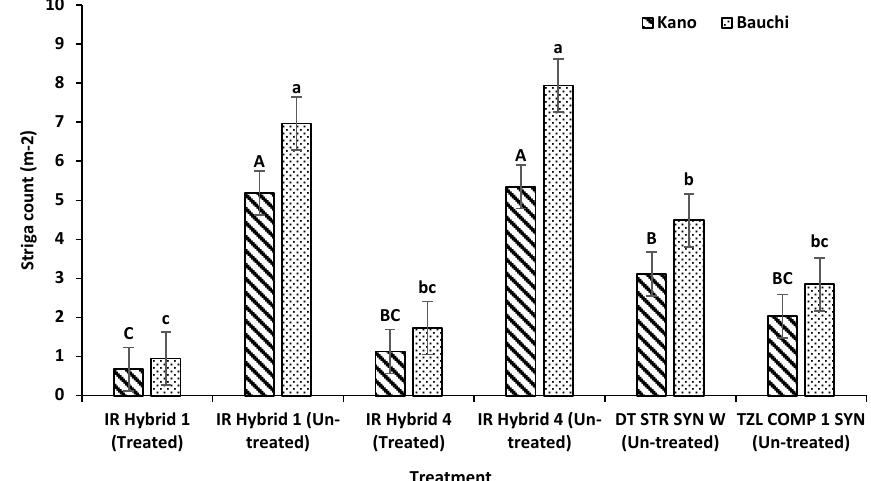
Figure 3. Effect of seed coating of IR maize hybrid with imazapyr on Striga count in farmers’ fields in Kano and Bauchi 2015.